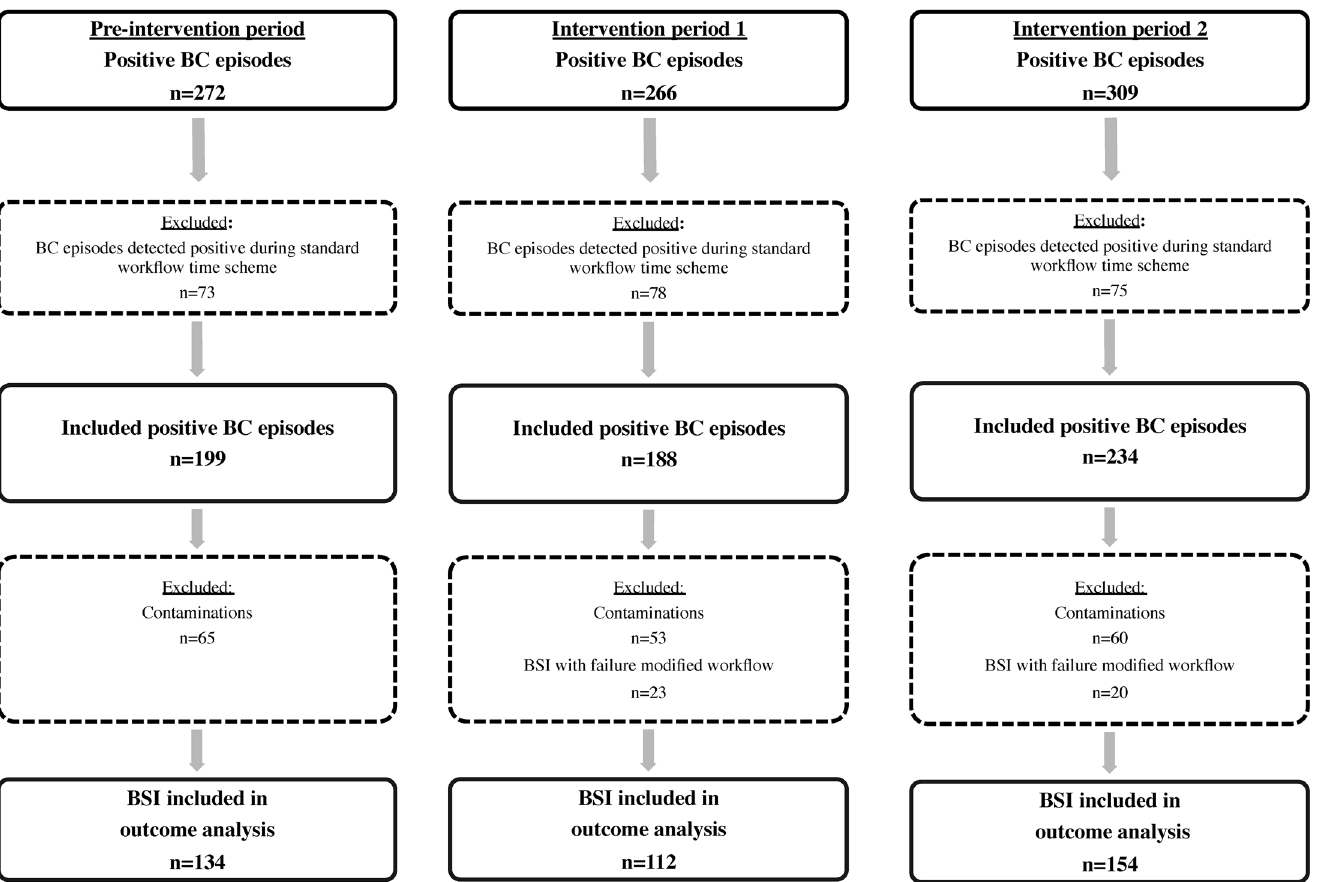
Fig 2. Flowchart of adult monomicrobial blood culture episodes included during pre-intervention and intervention periods. BC, blood culture; BSI, bloodstream infections.